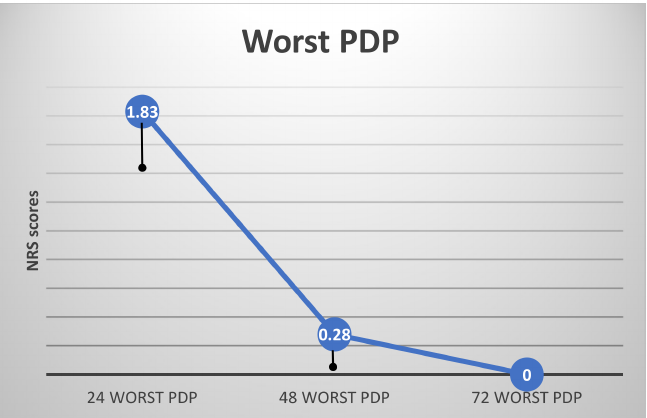
Figure 3. Worst PDP (entire population) (mean NRS scores, vertical lines indicate standard error).